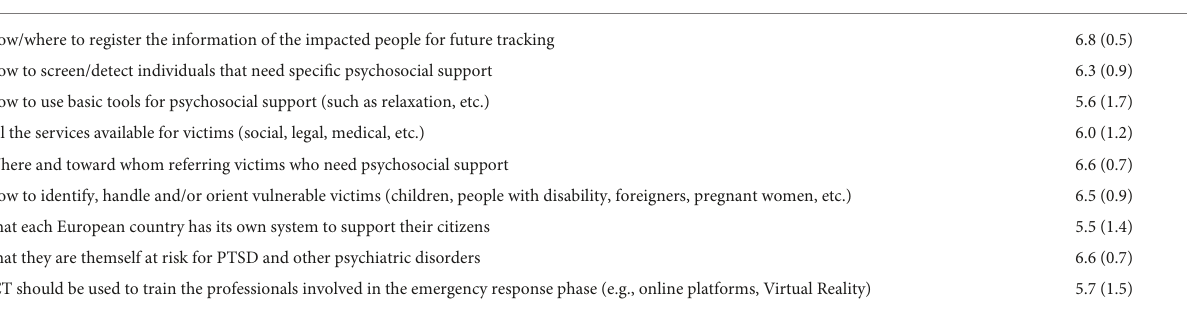
TABLE 1 Results of the rating questions.